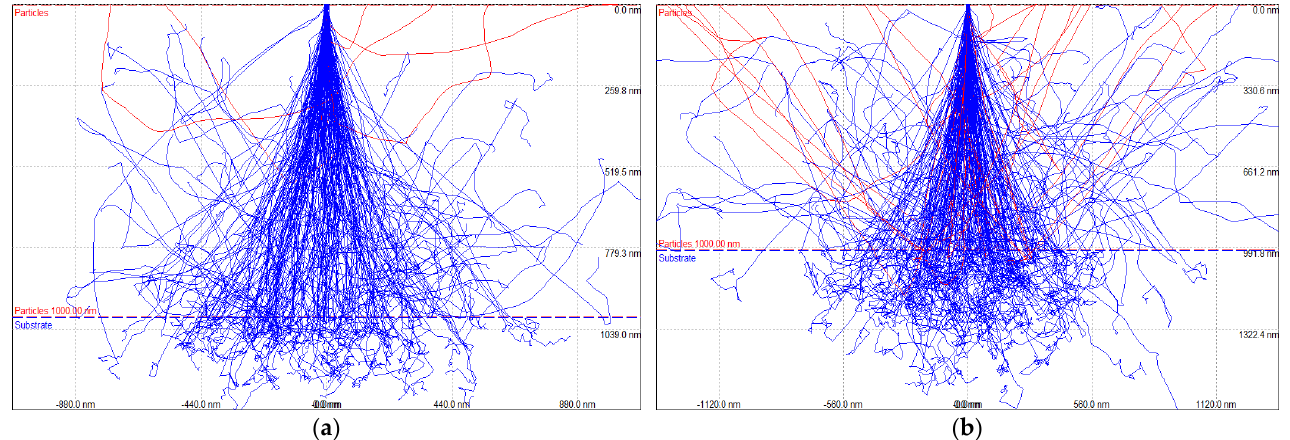
Figure 2. Monte Carlo simulation for accelerating voltage (AV) optimization of SEM-EDS ( a ) AV: 15 kV, interaction volume: depth = 1.0 μ m, ( b ) AV: 20 kV, interaction volume: depth = 1.3 μ m.